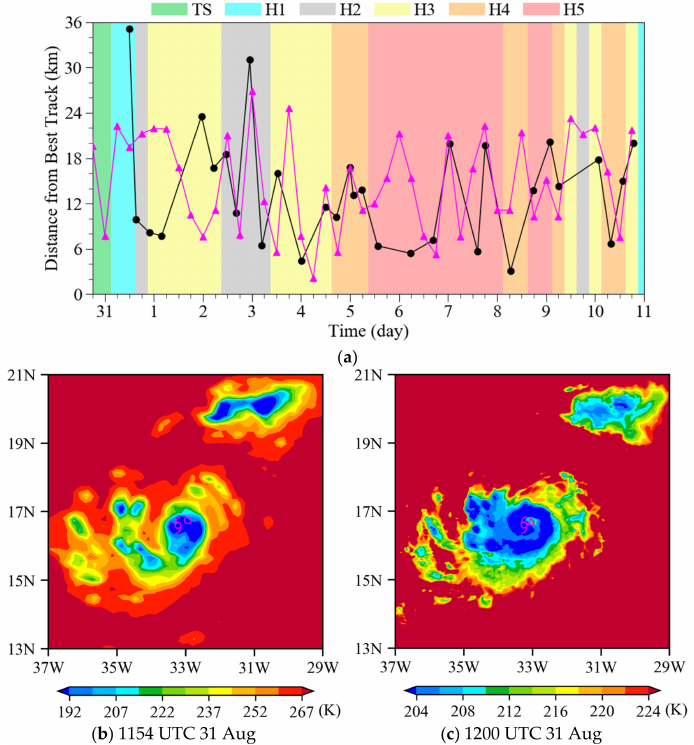
Figure 5. ( a ) Track errors of ABI channel 13-determined TC centers (solid triangles, magenta) and ATMS channel 18- or MHS channel 5-determined TC centers (solid circles, black) compared with the best track for Irma from 1800 UTC August 30 to 1800 UTC September 10, 2017. The mean distance between the best track centers for the ABI-determined centers or ATMS- or MHS-determined centers are about 14.9 and 13.8 km, respectively. Intensity categories (color shading) are shown in the legend above ( a ). ( b , c ) Spatial distributions of ( b ) MHS channel-5 and ( c ) ABI channel-13 TB observations (color shading; unit: K) around Hurricane Irma at about ( b ) 1154 and ( c ) 1200 UTC on August 31, 2017. The ABI-determined center (magenta open triangle), MHS-determined center (magenta open circle), and the best track center (magenta hurricane symbol) are also